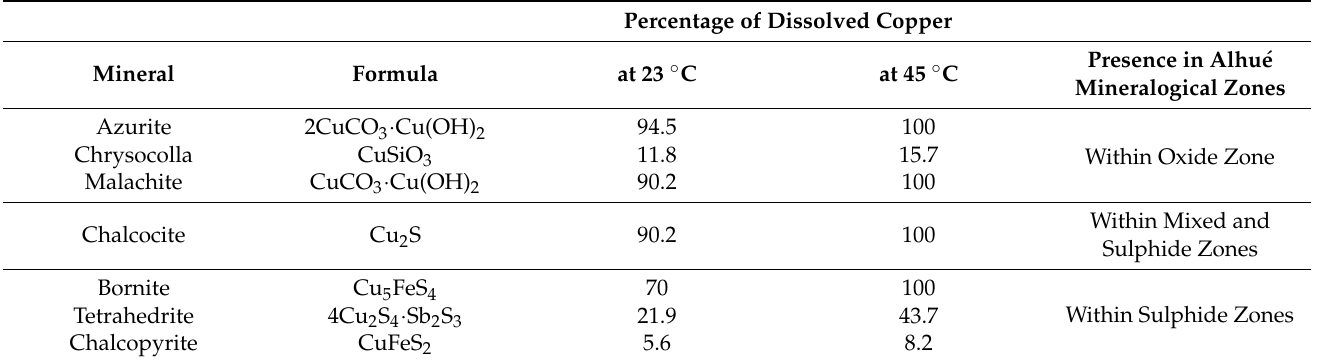
Table 1. Copper mineral solubilities in 0.1% NaCN solution